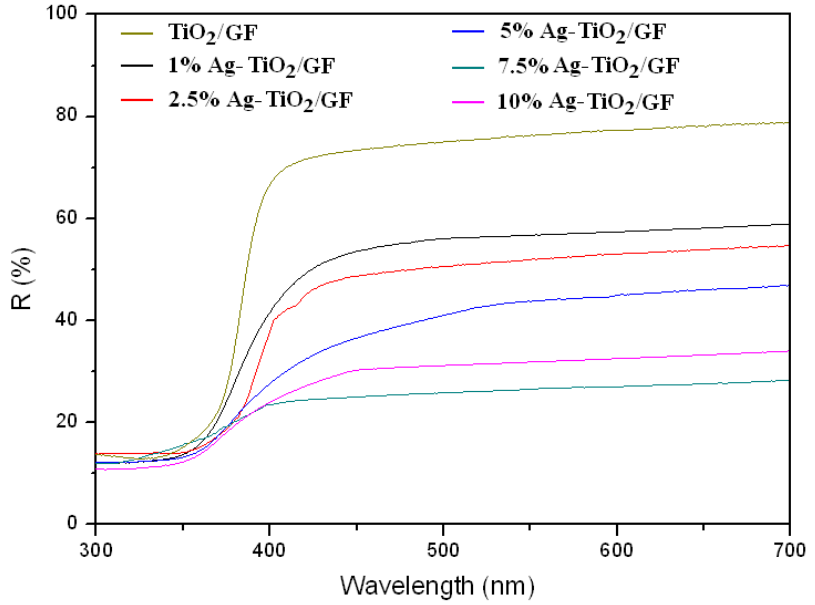
Figure 4. UV-Visible diffuse reflectance spectra of the TiO Ag-TiO 2